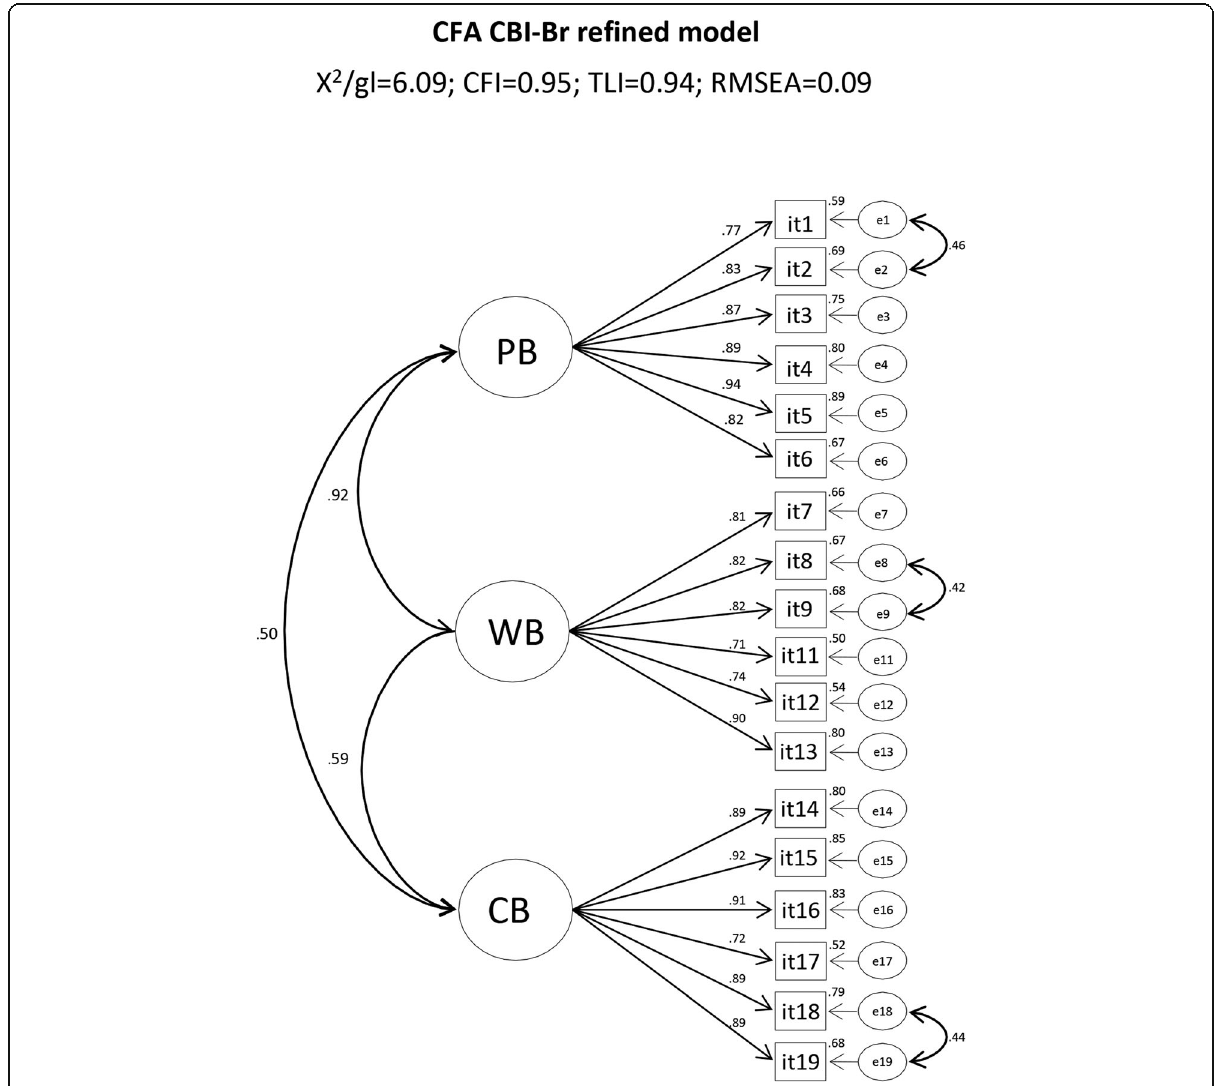
Fig. 1 Confirmatory factor analysis of CBI-Br refined model ( x 2 /df = 6.09; CFI = 0.95; TLI = 0.94; RMSEA = 0.09; IC90% = [0.081 –